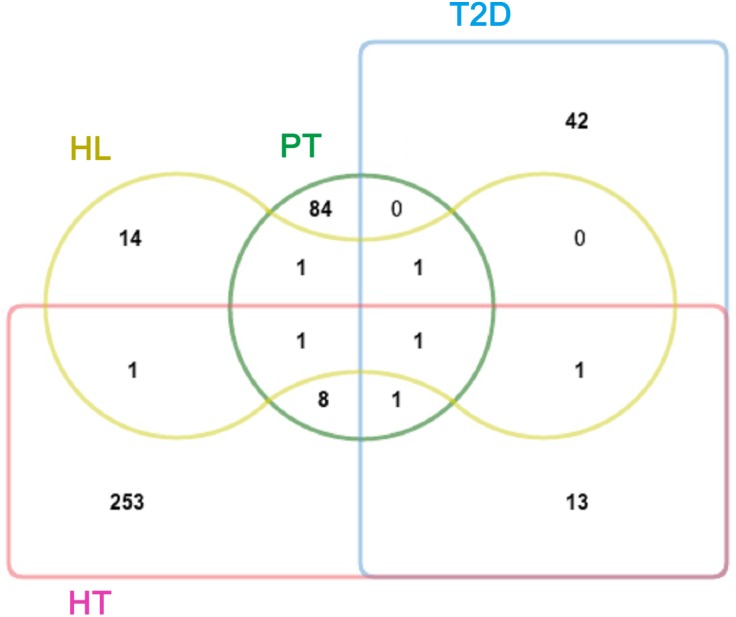
Venn diagram showing the overlap of significant targets in PT, T2D, HT, and HL.PT, putative targets, green; T2D, type II diabetes, blue; HT, hypertension, pink; and HL, hyperlipidemia, yellow.